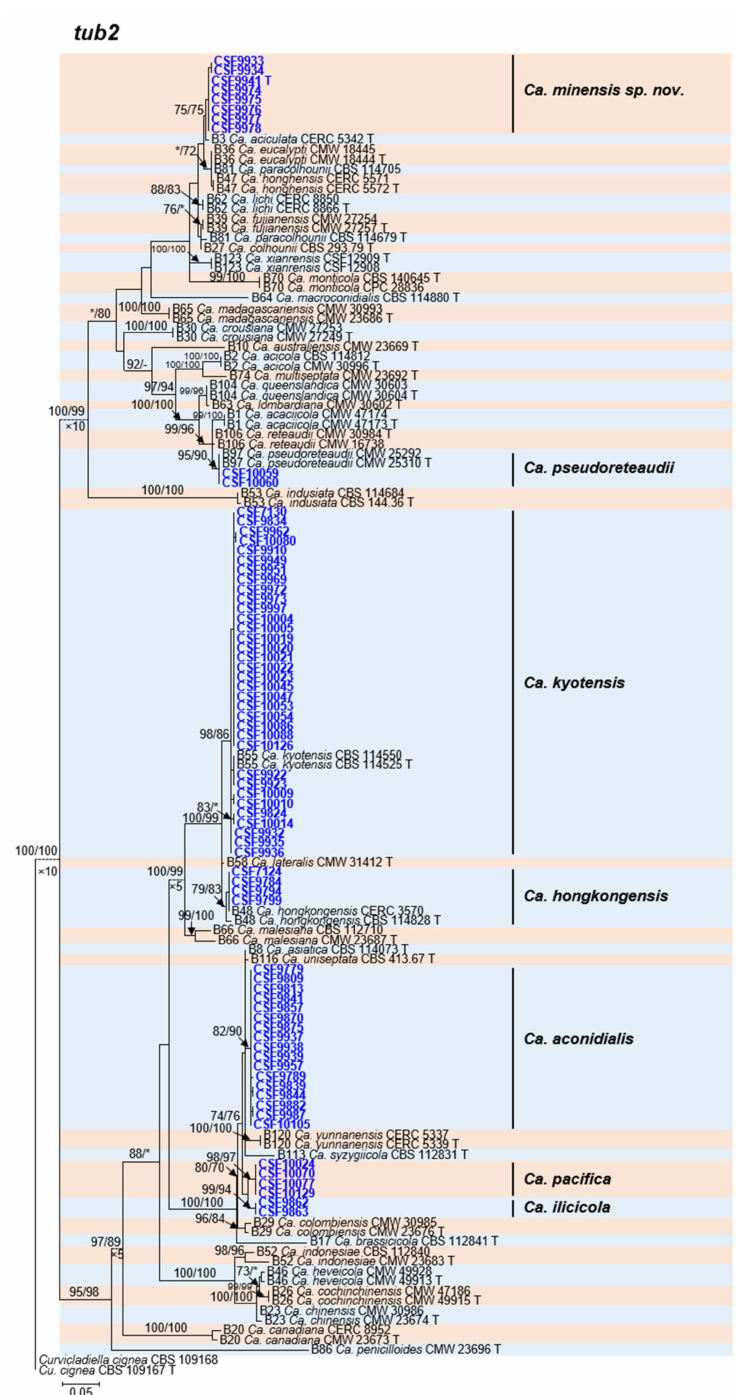
Figure A6. Phylogenetic tree of Calonectria species based on maximum likelihood (ML) analyses of tub2 gene sequences. Bootstrap value ≥ 70% for ML and MP analyses are presented at the branches. Bootstrap values lower than 70% are marked with “*”, and absent analyses values are marked with “-”. Ex-type isolates are marked with “T”. Isolates sequenced in this study are highlighted in